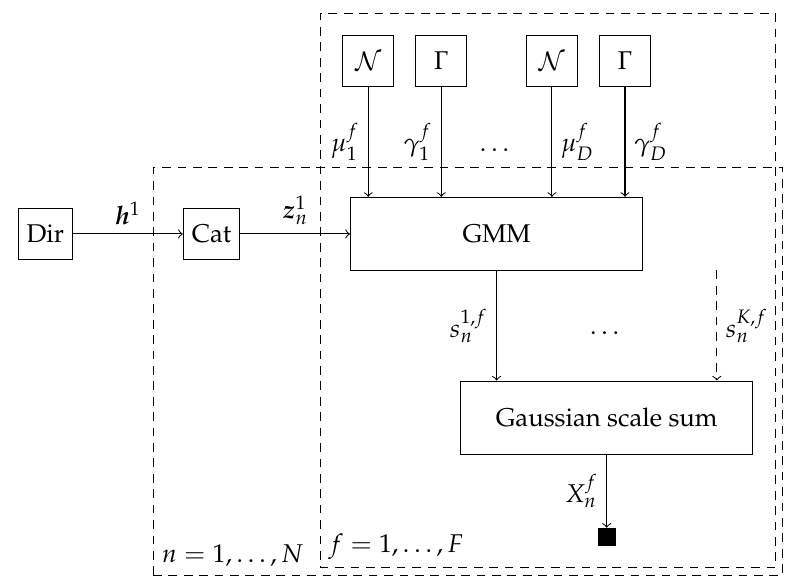
Figure 6. The Forney-style factor graph representation of the Gaussian scale sum-based generative model fully specified by (11)–(16). The GMM composite node represents the Gaussian mixture node as specified in ([37], A.2). The Gaussian scale sum composite node has been summarized in Table 2. The dashed rectangular bounding boxes here denote plates, which represent repeating parts of the graph. Edges that are intersected by the plate boundaries are implicitly connected between plates using equality nodes.